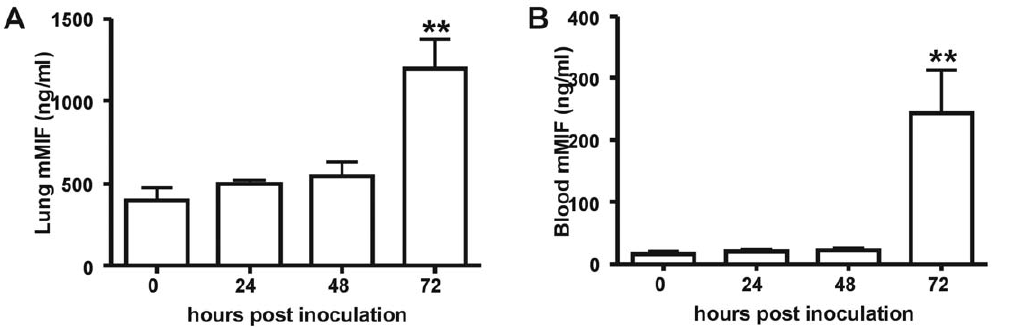
Figure 2. Increased MIF concentrations during experimental melioidosis in mice. Pulmonary MIF expression was strongly increased 72 hours after intranasal inoculation with B. pseudomallei ( A ). Plasma MIF concentrations remained constant during the first two days of infection, followed by a steep increase over time ( B ). Data are means 6 SEM of 5 mice per group at each time point. ** p , 0.01 versus t=0.